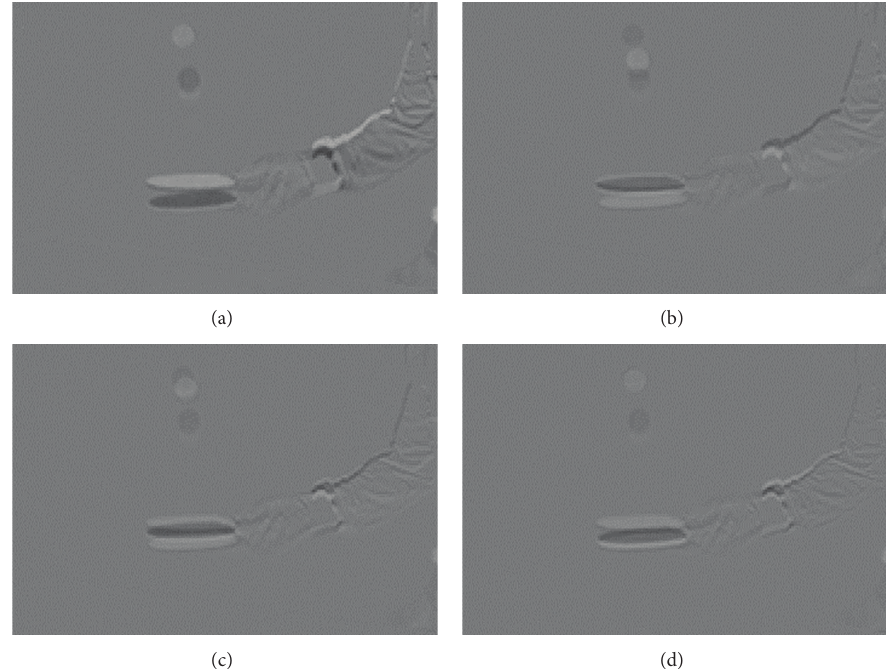
Figure 5: (a) Δ -frame from Frame 5 in 𝑉 band, (b) R-frame from Frame 2 in 𝑉 band, (c) R-frame from Frame 3 in 𝑉 band, and (d) R-frame from Frame 4 in 𝑉